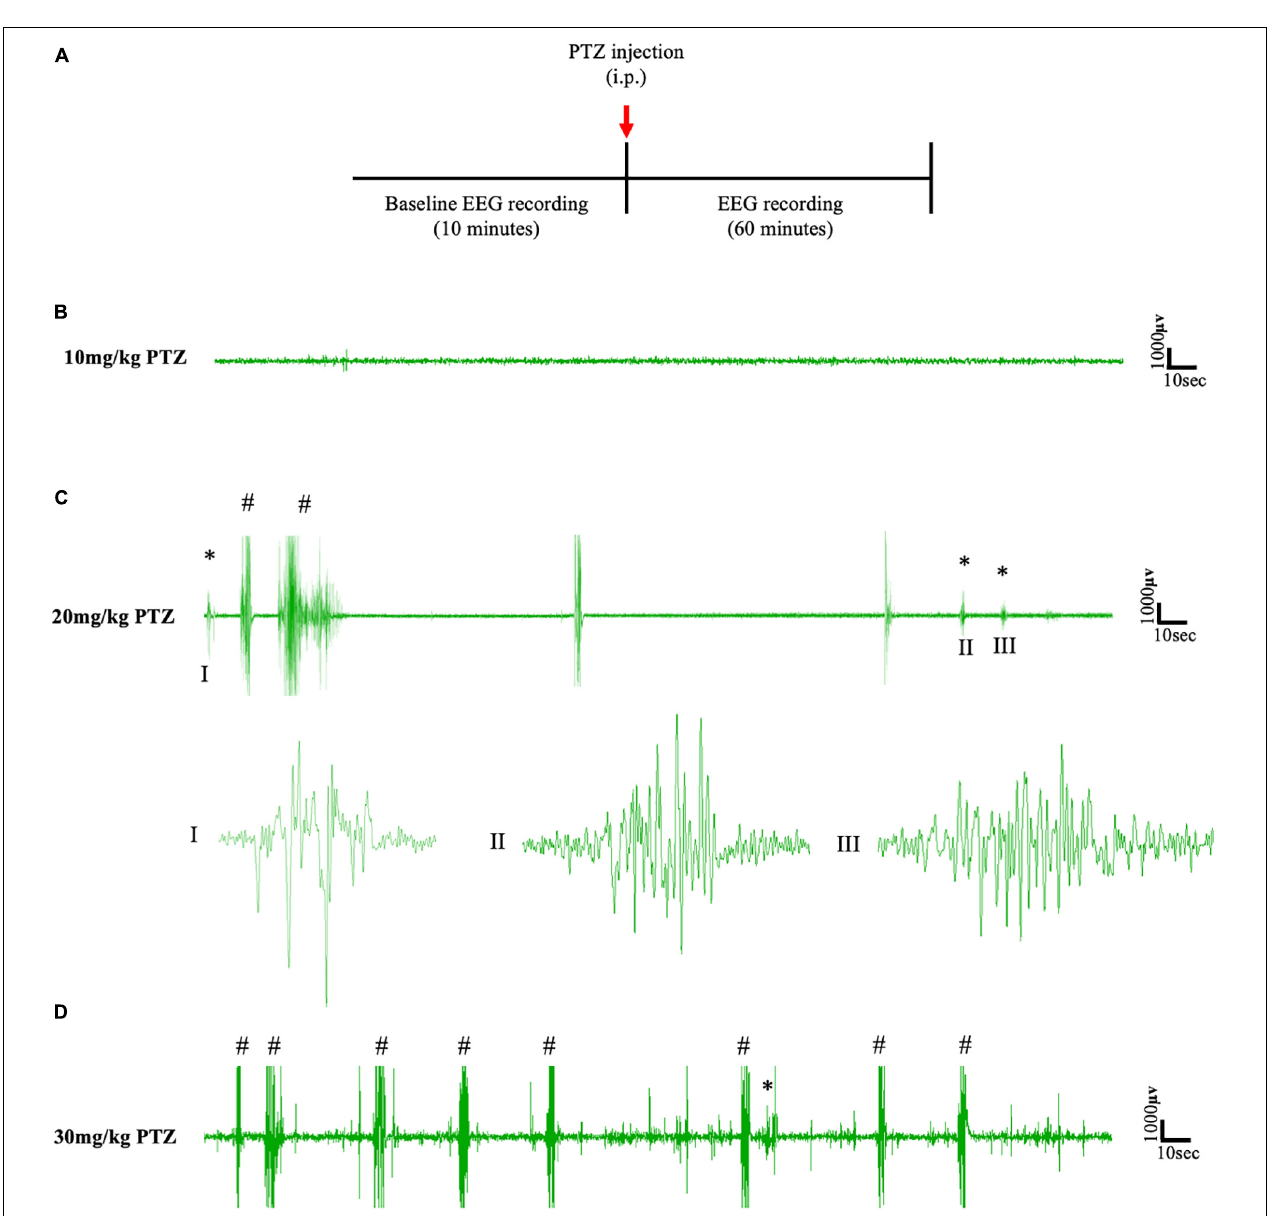
FIGURE 2 | (A) Schematic protocol for EEG recordings before and after IP PTZ injection in the pilot study. Representative EEG traces from animals after (B) 10 mg/kg (C) 20 mg/kg (D) 30 mg/kg of PTZ injection. Asterisks ( ∗ ) and hash signs (#) represent absence-like seizures and tonic-clonic seizures, respectively. Each trace represents 5 min of EEG recording. All representative EEG traces were obtained from different